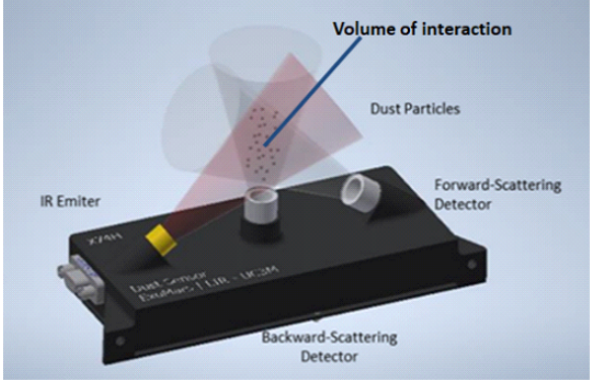
Figure 2. Dust sensor